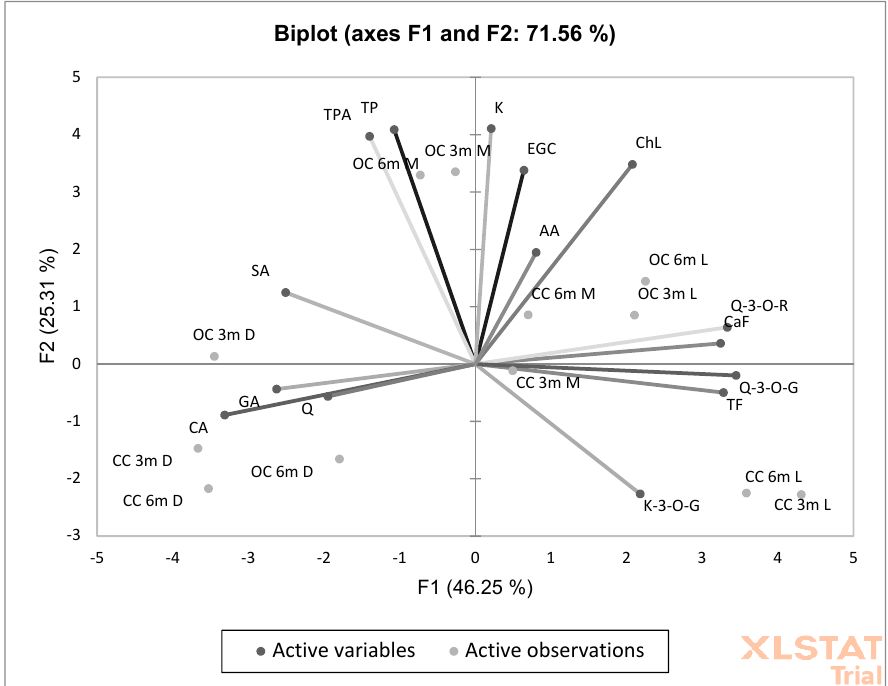
Figure 3. Principal component analysis (PCA) analysis showing the relationship between the chemical composition and roasting and brewing times in organic and conventional coffee. (CaF) caffeine; (TP) total polyphenols; (TPA) total phenolic acids; (GA) gallic acid; (ChL) chlorogenic acid; (CA) caffeic acid; (SA) salicylic acid; (FA); (TF) total flavonoids; (TFl) total flavonols; (EGC) epigallocatechin; (Q-3-O-R) quercetin-3-O-rutinoside; (Q-3-O-G) quercetin-3-O-glucoside; (K-3-O-G) kaempferol-3-O-glucoside; (Q) quercetin; (K) kaempferol.